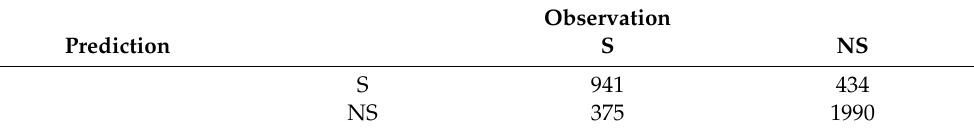
Table 5. Theoretical model